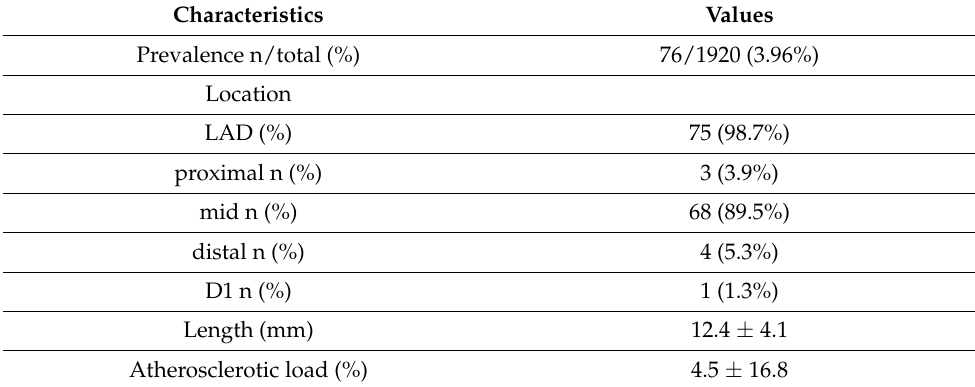
Table 1. Characteristics of the myocardial bridge.